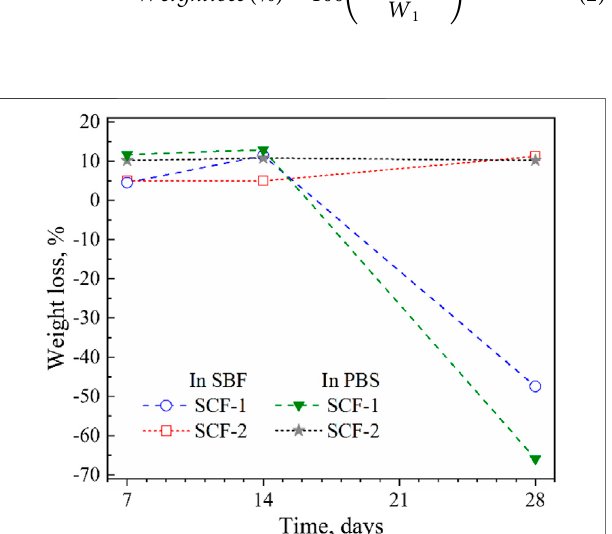
FIGURE 7 | Average weight loss and gain of immersion of scaffolds into SBF and